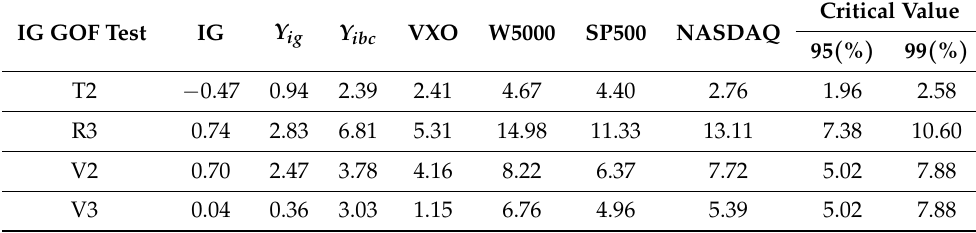
Table 1. IG Goodness of Fit(GOF)